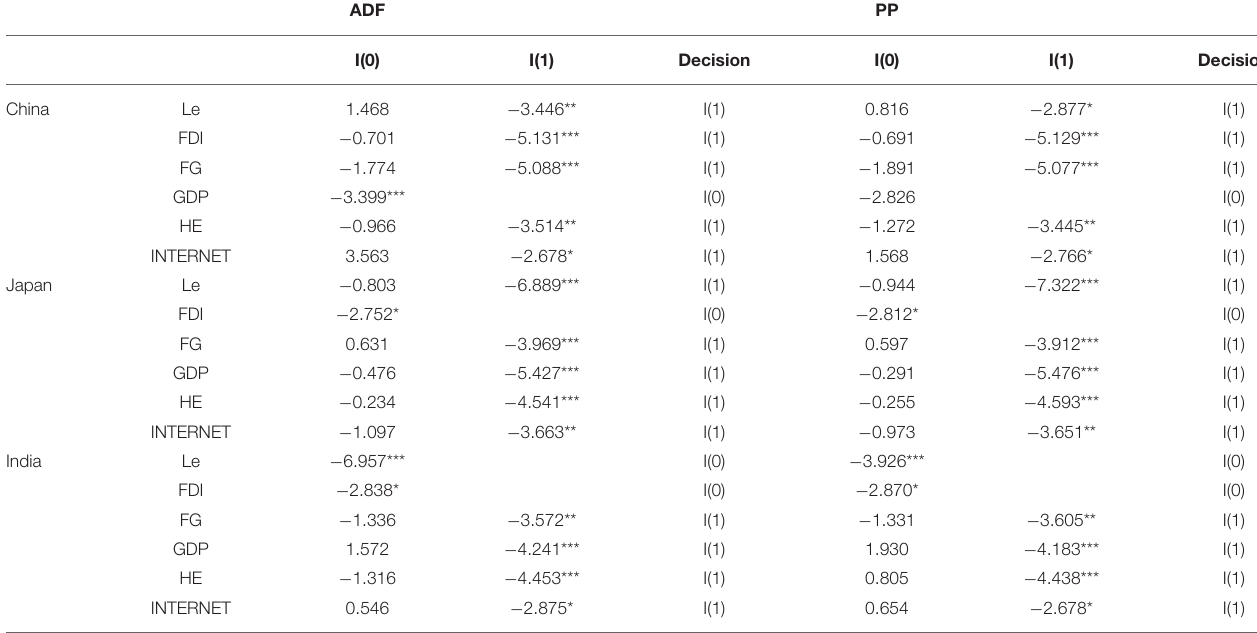
TABLE 2 | Unit root test.